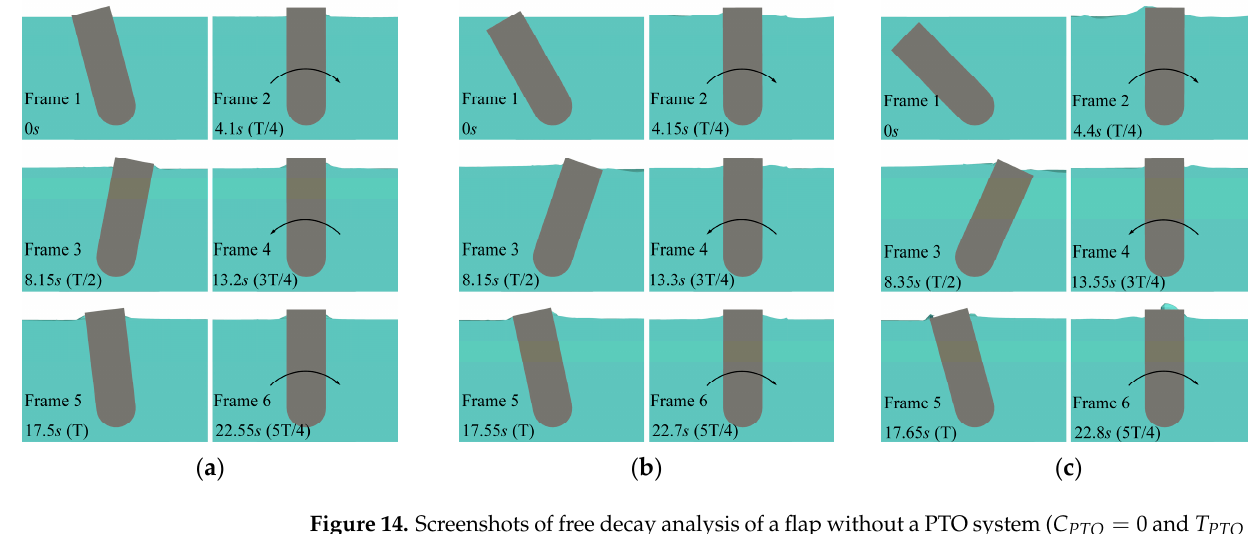
Figure 14. Screenshots of free decay analysis of a flap without a PTO system ( C PTO = 0 and T PTO = 0) and with different initial angles in CFD: ( a ) 15 deg.; ( b ) 30 deg.; ( c ) 45 deg.